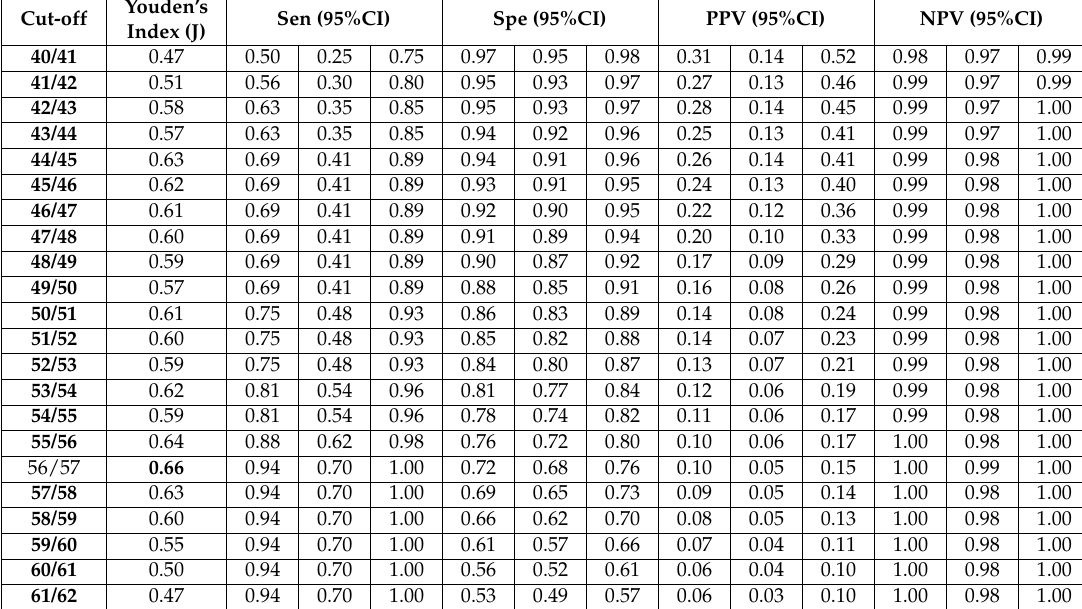
Table 3. Sensitivity (Sen), Specificity (Spe), Positive Predictive Value (PPV), Negative Predictive Value (NPV, with 95% confidence intervals (CI), for different Quick Mild Cognitive Impairment (Q mci -J) screen cut-off scores for suspected cognitive impairment (suspected dementia), without adjustment for age or education, compared with normal controls.